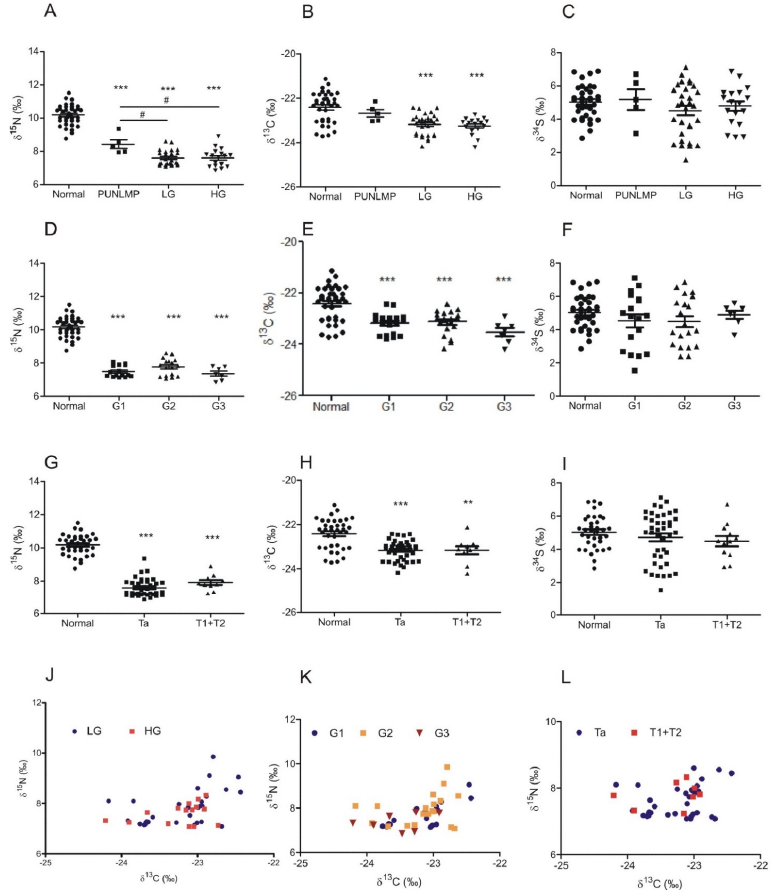
Figure 2. The abundance of 15 N, 13 C, and 34 S isotopes in relation to bladder cancer grade according to the WHO 2004/2016 ( A – C ) and WHO 1973 ( D – F ) classification systems and TNM stage classifi- cation ( G – I ) (mean ± SEM). Scatter plots showing the abundance of isotope pairs ( δ 13 C— δ 15 N, δ 13 C– δ 34 S, and δ 34 S– δ 15 N, respectively) in each sample of bladder cancer in relation to tumor grade and stage ( J – L ). ** ( p < 0.01) and *** ( p < 0.001) indicate significant differences when compared to normal tissue; # ( p < 0.05) show significant differences between PUNLMP and low/high grade (LG/HG) bladder